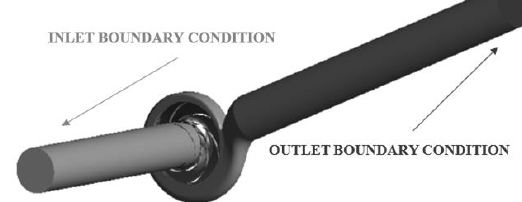
Fig. 8. Computational domain of inducer with pump [3]